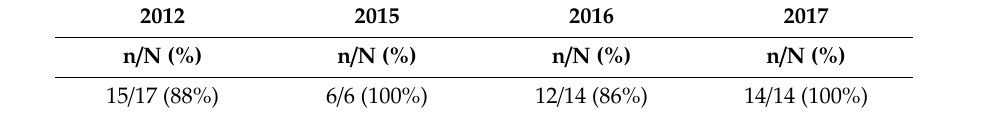
Table 4. Number of malaria cases among migrants detected through Pro-Active Case Detection program, Municipality of Evrotas, 2012–2017.